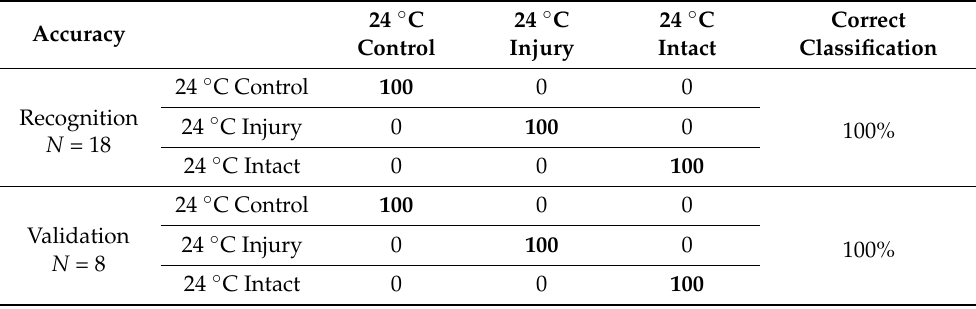
Table 8. LDA classification model on the e-tongue data of control and infected plum juices stored at 24 ◦ C with first parallel sample validation when the inoculation mode was used as class variable ( N =